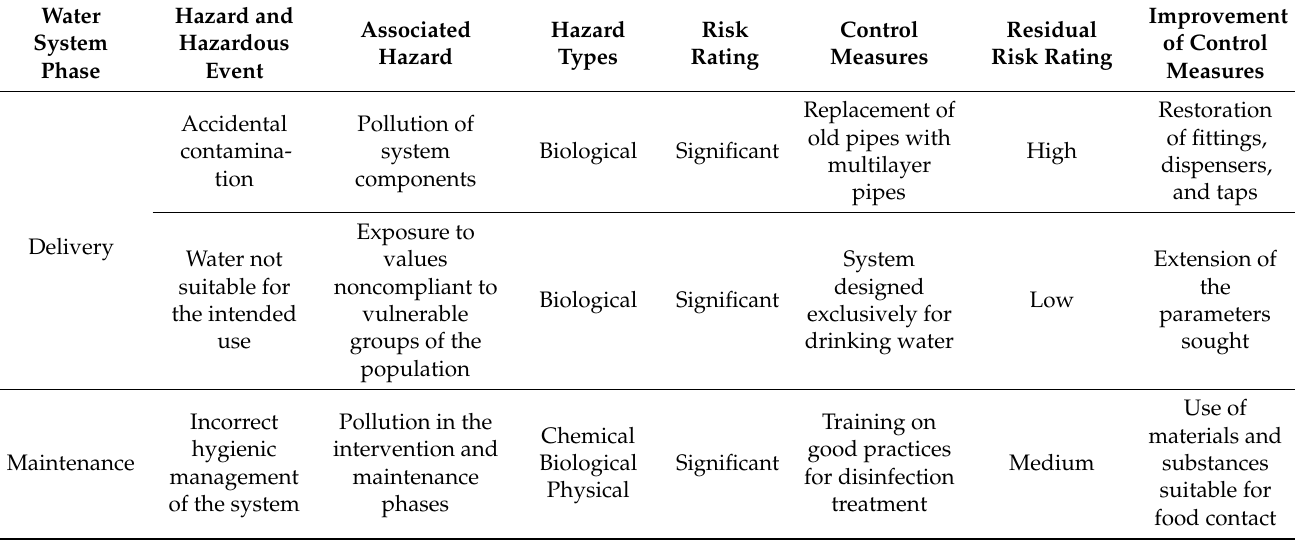
Table 3. Identification of hazards and dangerous events: Case Study 2—AQP